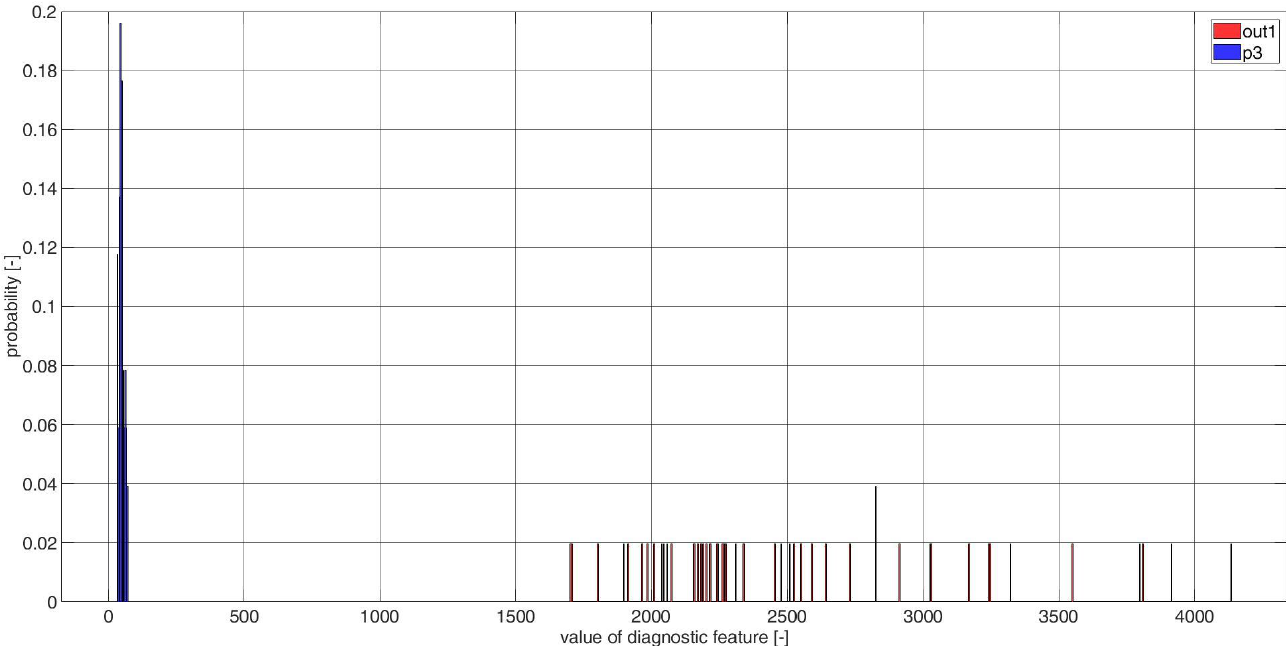
Figure A28. Histograms of diagnostic features based on the CCSM3 (correlation number is 1 — Table A2) bearings out2 and p4.